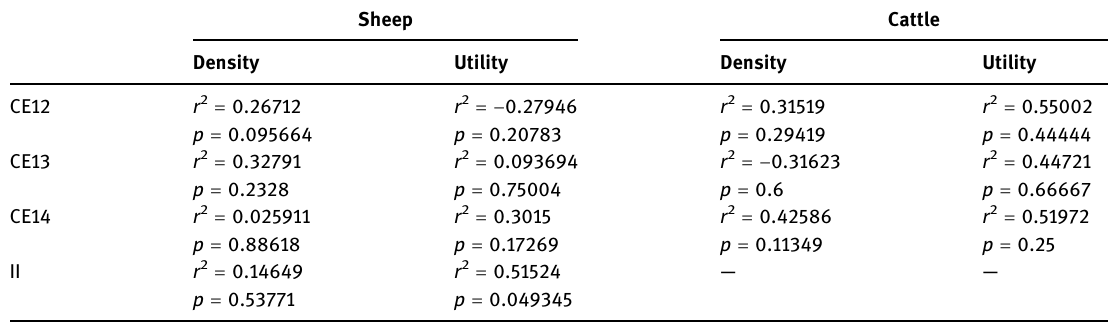
Table 3: Spearman ’ s rho correlation of %MAU and the density and utility indices of the levels and structures of CE and CV that present more than 10 sheep/goats or cattle